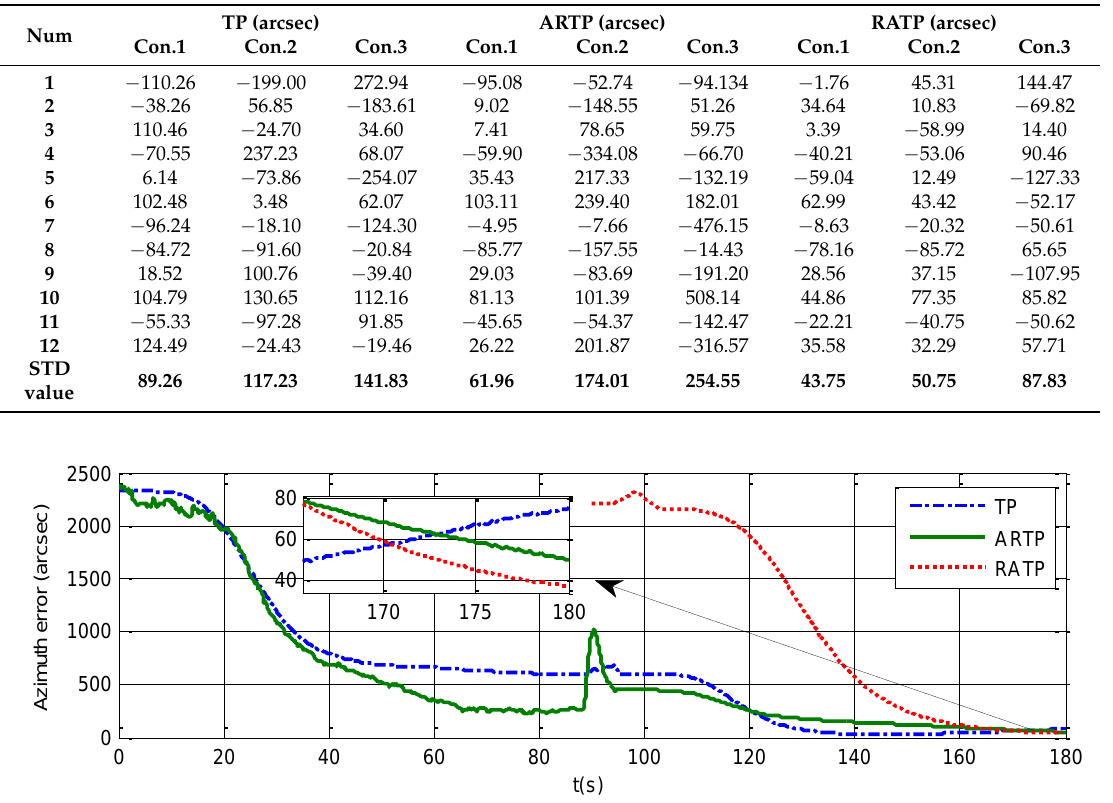
Figure 7. Azimuth error time history curve under stationary conditions when the total alignment time is 180 s.